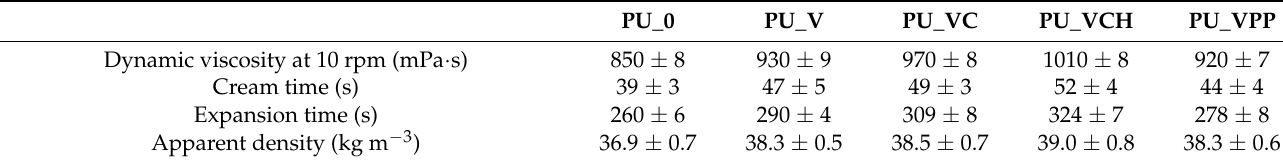
Figure 2. The results of the particle size distribution. Table 1. Rheological properties of polyurethane composites.